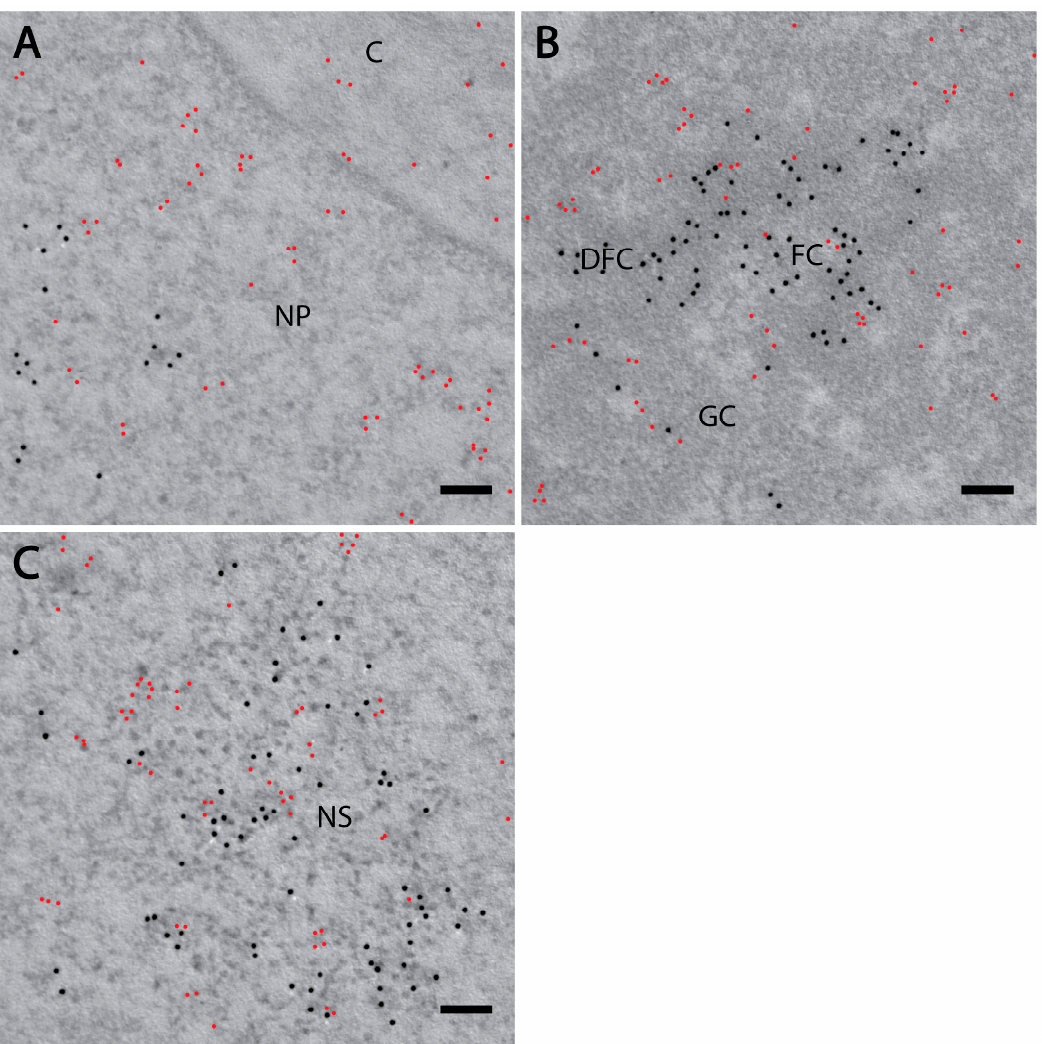
Figure 4. PI(4)P forms different foci than PI(4,5)P2. Electron microscopy showed the localisation of PI(4)P (red) and PI(4,5)P2 (black) are different in the nucleoplasm. Localisation of PI(4)P visualised with OSH1-PH domain and PI(4,5)P2 visualised with antibody ( A ) in the nucleoplasm and nuclear envelope, ( B ) in the nucleolus and ( C ) in the nuclear speckles. NP—nucleoplasm, C—cytoplasm, FC—fibrillar centre, DFC—dense fibrillar component, GC—granular component, NS—nuclear speckle. Scale bars: 500 nm.